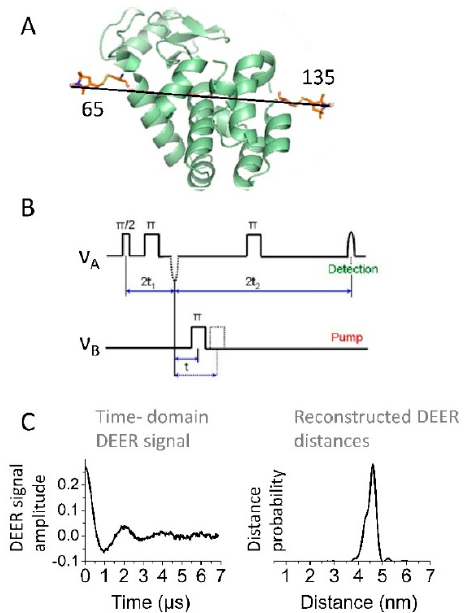
Figure 3. Double electron–electron resonance (DEER) distance measurements in doubly spin-labeled protein molecules. ( A ) The method is illustrated with T4 lysozyme (PDB accession code 3LZM) doubly spin-labeled at positions 65C and 135C. The spin label side-chains were generated with the program MMM. The measured inter-spin distance is indicated by the line. ( B ) The four-pulse microwave (MW) sequence that is used most often in the DEER experiment. The electron spins corresponding to different spin-labeled sites are frequency-selected for detection or pumping, respectively. The three MW pulses separated by fixed intervals select one of the spins to contribute to the detected spin-echo signal. The 4th (pump) pulse applied at a different frequency may select a coupled spin within the respective region of the spectrum. The pump pulse delay is advanced to give the spin-echo amplitude modulation envelope caused by dipolar coupling between the paired electron spins. ( C ) The recorded time-domain DEER signal (left) and the respective distances (right) between the MTSSL spins at residues 65C and 135C are shown. In general, a decaying oscillating time-domain signal is obtained from which the inter-spin distances and distance distributions are reconstructed.